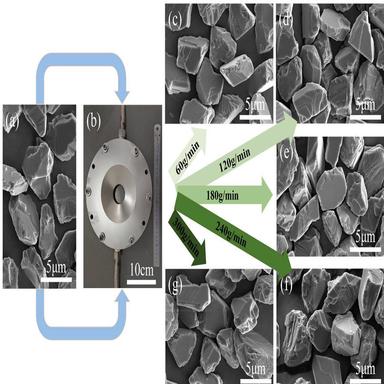
(a) Original cBN powder; (b) Spray tray; (c) Recycled at 60 g/min powder flow rate; (d) Recycled at 120 g/min powder flow rate; (e) Recycled at 180 g/min powder flow rate; (f) Recycled at 240 g/min powder flow rate; (g) Recycled at 300 g/min powder flow rate.